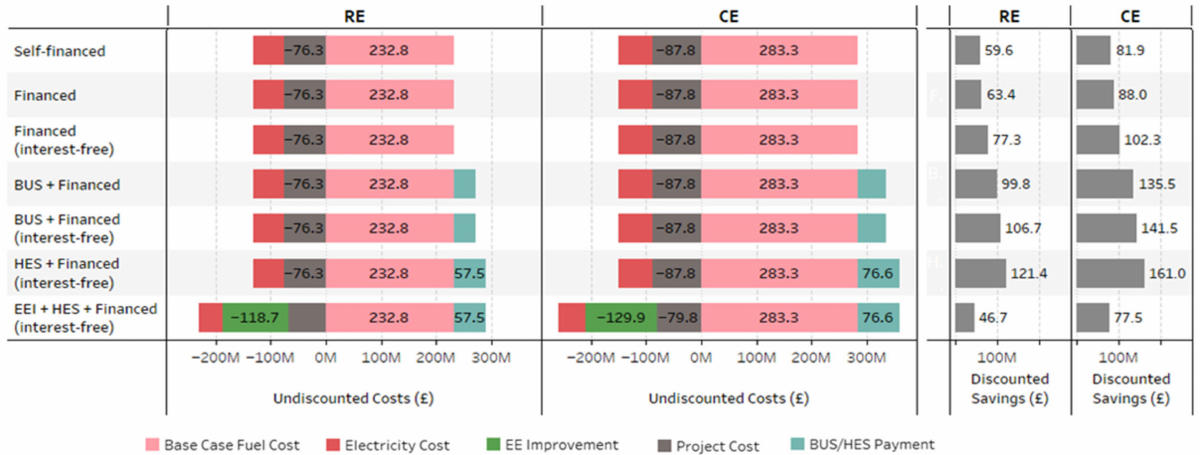
Figure 15. Cumulative undiscounted cost distribution of replacing heating technologies with heat pumps in Orkney for different financial alternatives and future scenarios by fuel